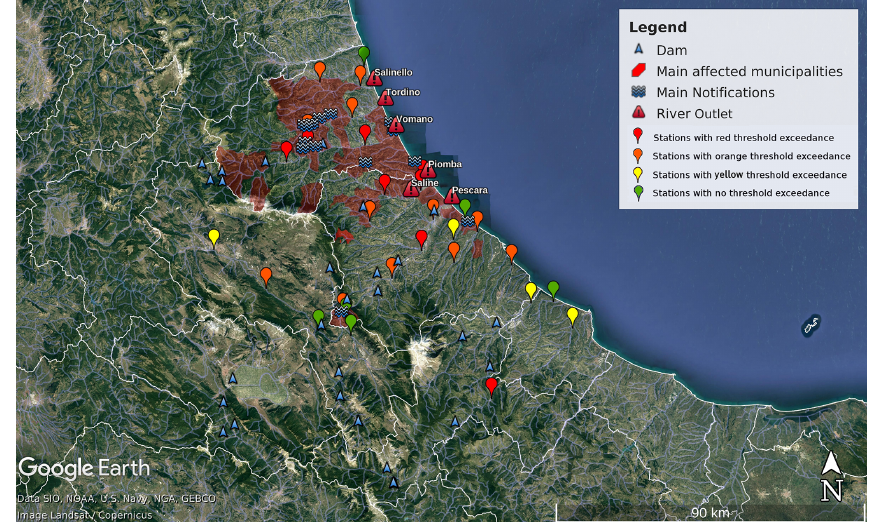
Figure 4. Geo-referred information of the ODB for CS03, Abruzzo region, with localization of main recorded floods (blue waves), hydro- metric stations used for the indices’ validation (pinpoints). Red triangles indicate the position of outlets of the main rivers involved, while blue triangles indicate the presence of dams. Hydrometric station pinpoints are coloured according to the maximum hydrometric threshold reached during the event. Municipality areas affected by flooding are filled in red. © Google